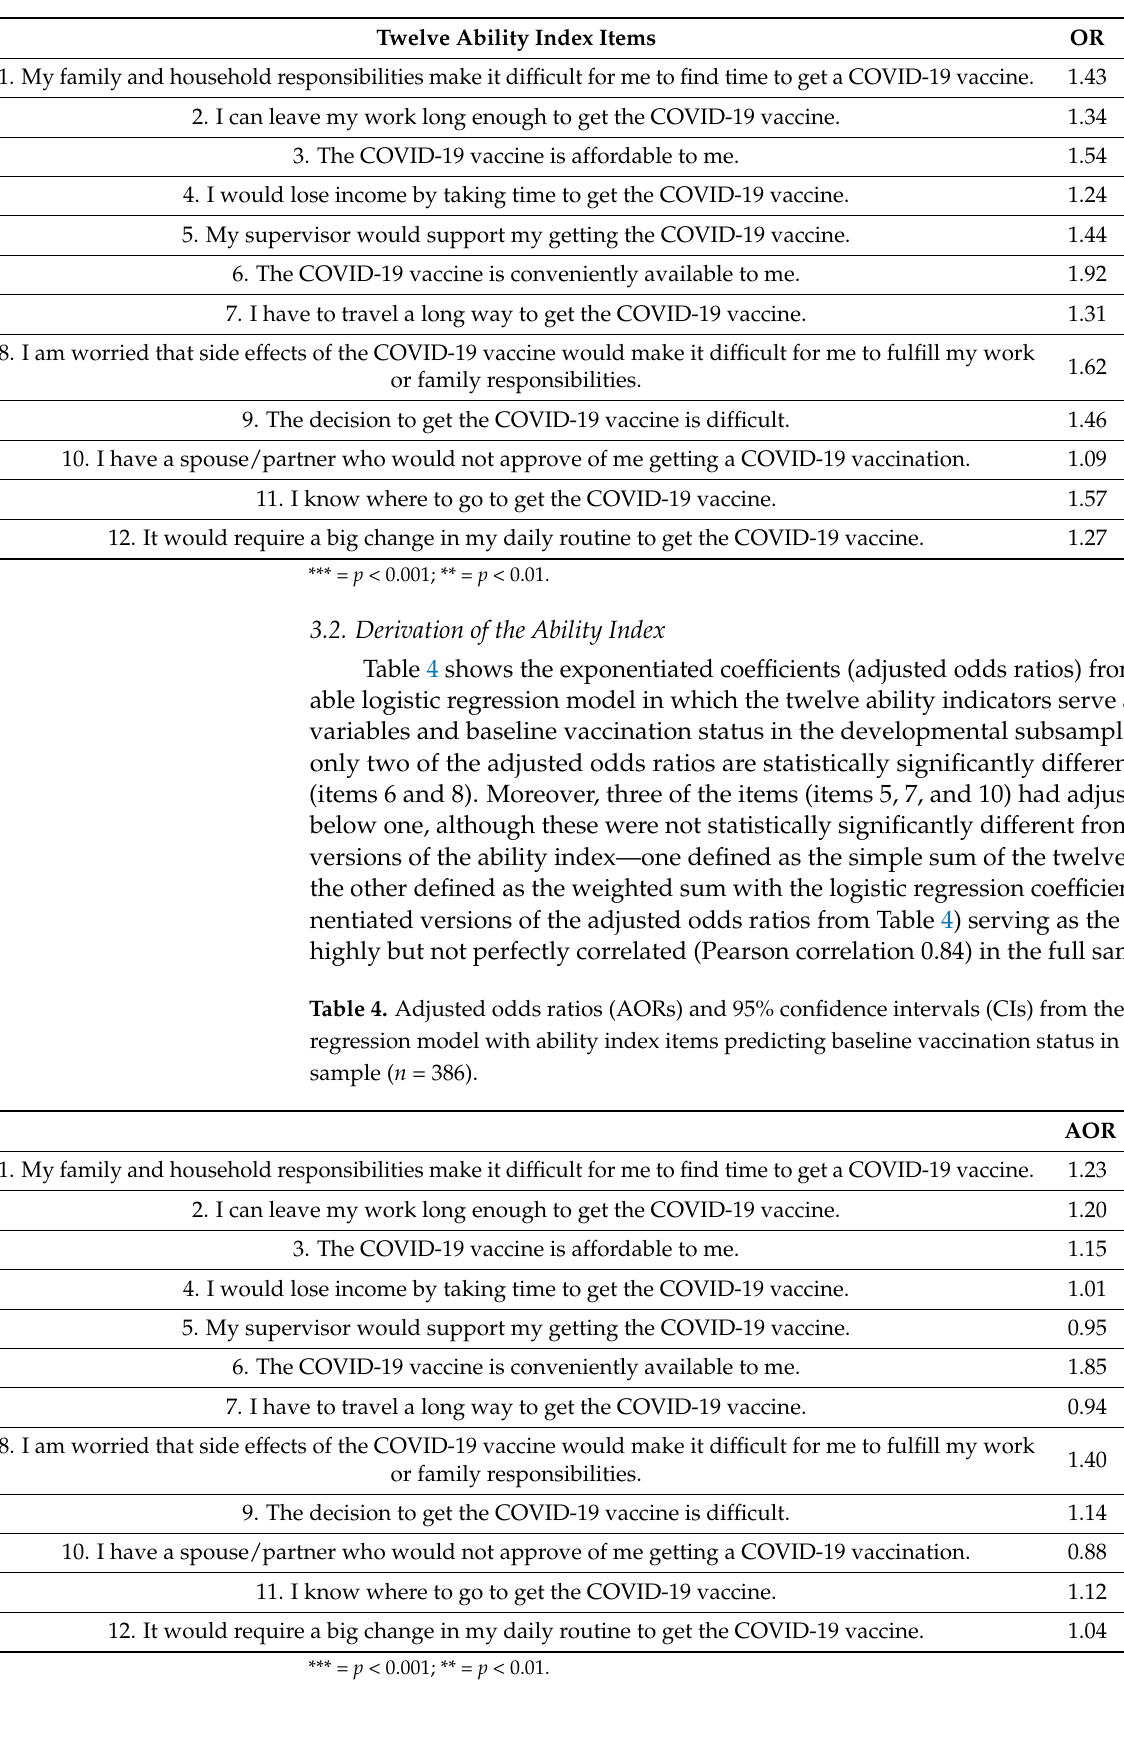
Table 3. Associations between ability index items and baseline vaccination ( n = 781).